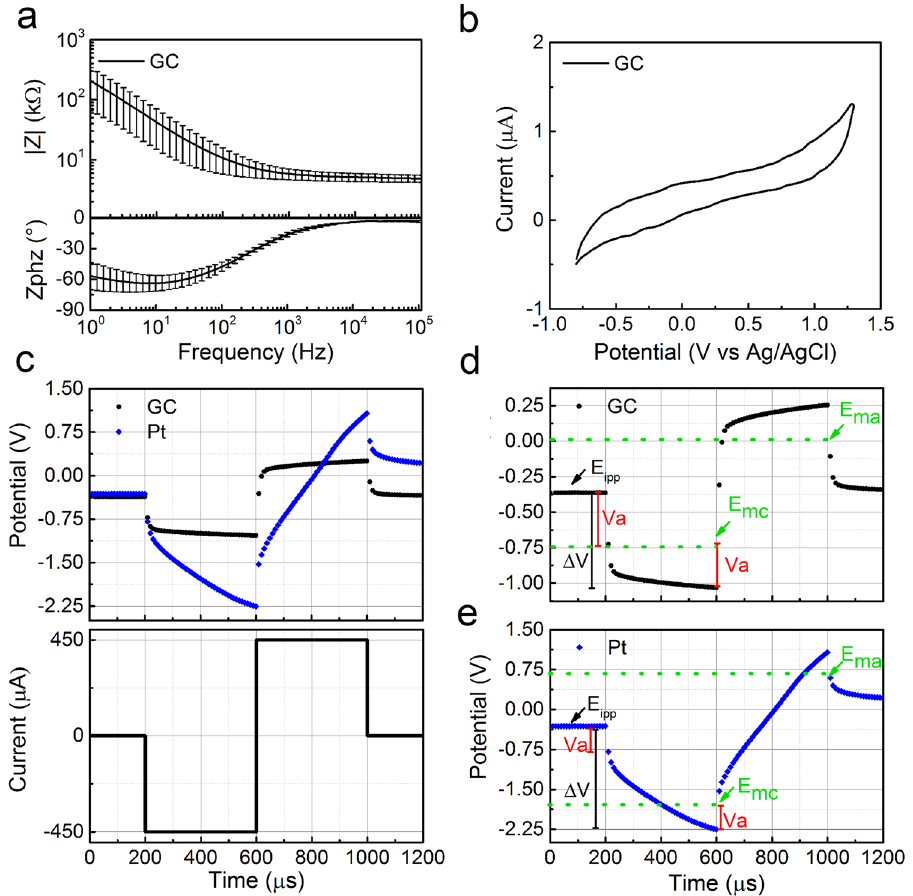
Figure 4. Electrochemical characterization of GC microelectrodes. ( a ) EIS plot (mean and standard deviation, n = 10), ( b ) representative cyclic voltammogram, ( c ) comparison of the voltage transient of GC versus Pt microelectrodes in response to a biphasic, symmetric 450 µ A current pulse, ( d ) voltage transient response of GC microelectrode, ( e ) voltage transient response of Pt microelectrode. Both plots show the components that contribute to the voltage transients (i.e., V a , E ipp , E mc and E ma ). E ipp is the inter-pulse potential. V a is defined as the near-instantaneous voltage change at either the onset of the current pulse or immediately after the current pulse is terminated. It is associated with the Ohmic electrolyte resistance and overpotential terms 18 . Maximum positive polarization E ma = V max,pos − V a whereas the maximum negative polarization E mc = V max,neg − V a . The values of E mc and E ma for GC and Pt are ( − 0.75 V, 0 V) and ( − 1.75 V, 0.75 V) respectively, indicating a lower overpotential and lower-threshold for electrochemical kinetics of GC